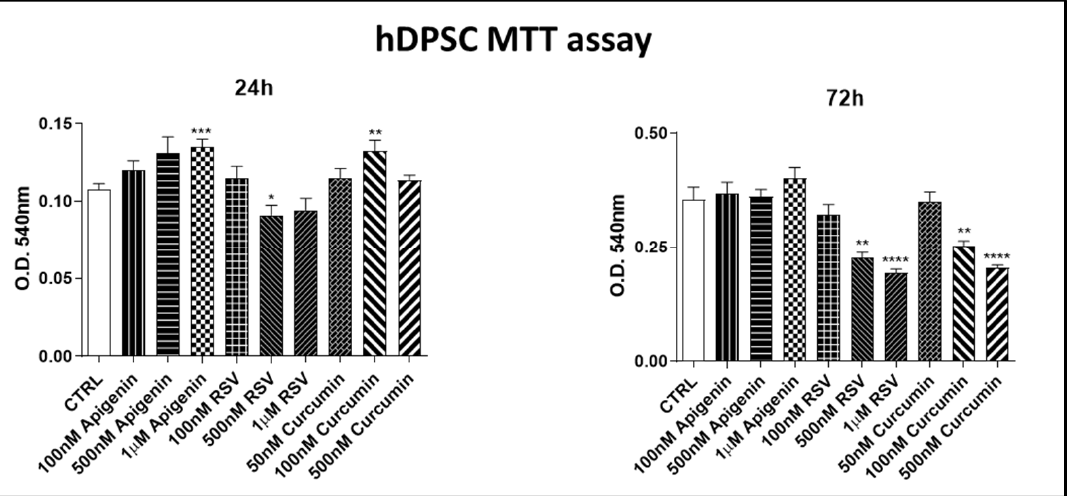
Figure 2. MTT assay on hDPSC cultures at low concentrations. At 24 and 72 h, apigenin was tested at final concentrations of 1 µM, 500 and 100 nM; resveratrol 1 µM, 500 and 100 nM; and curcumin 50, 100, and 500 nM. Data derived from means ± SEM of three different experiments (each n = 3), * p ≤ 0.05, ** p ≤ 0.01, *** p ≤ 0.001, **** p ≤ 0.0001.